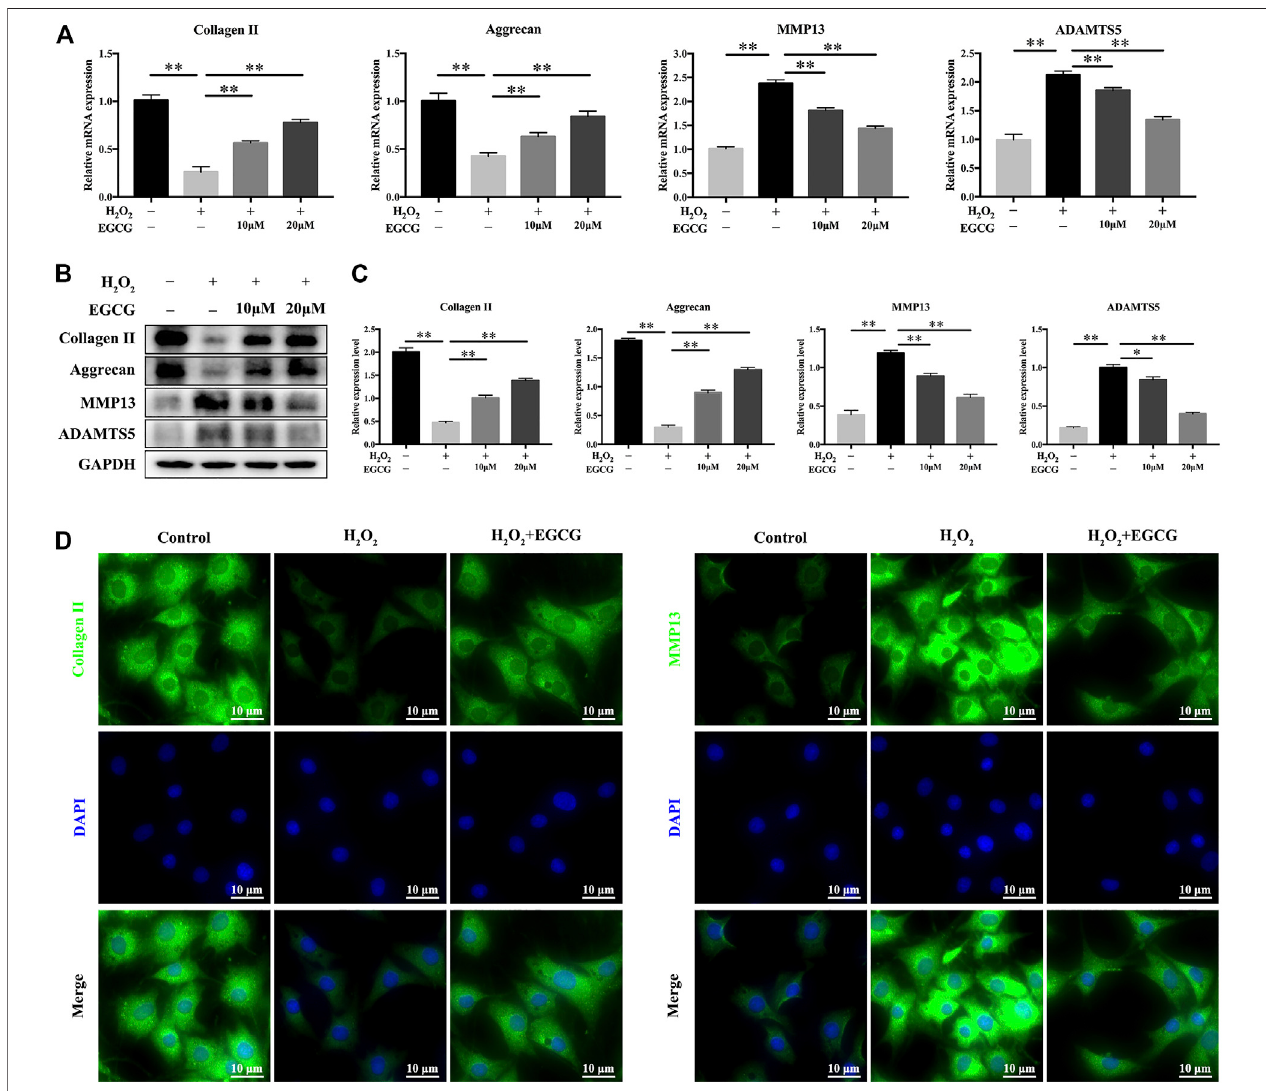
FIGURE 2 | EGCG attenuates H 2 O 2 -induced ECM degradation in NPCs. (A) NPCs were pretreated with EGCG for 4 h and then stimulated with H 2 O 2 for 24 h, qPCR results showing expression levels of Collagen II, Aggrecan, MMP13, and ADAMTS5. (B) Western blot fi ndings of protein expression levels. (C) Quanti fi cations of signal intensities. GAPDH was the loading control. (D) Immuno fl uorescence of Collagen II as well as MMP13 in NPCs. Data are shown as mean ± SD ( n (cid:2) 3). * p < 0.05, ** p < 0.01.